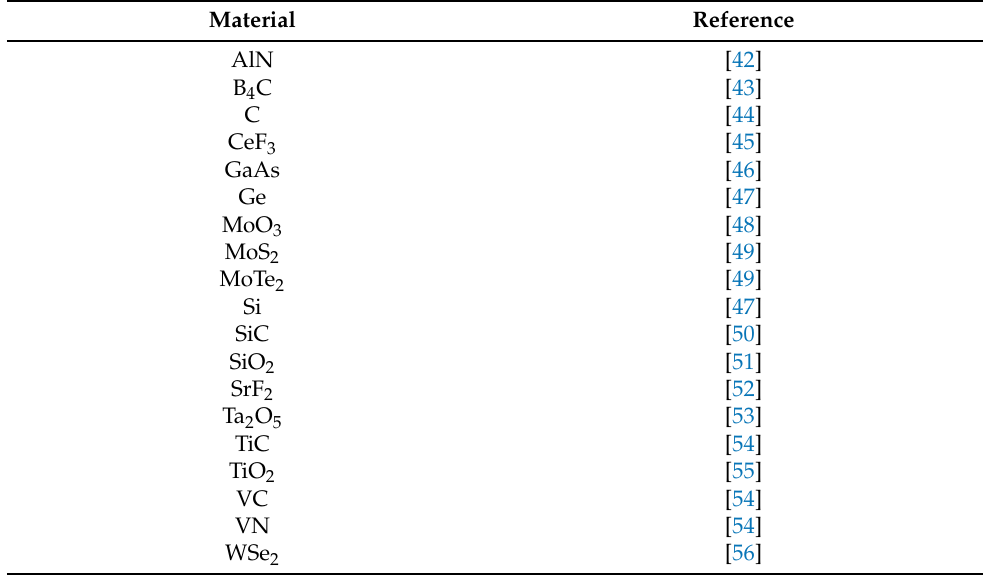
Table 1. Materials used for database generation. Refractive index data were extracted from Refrac- tiveIndex.INFO website